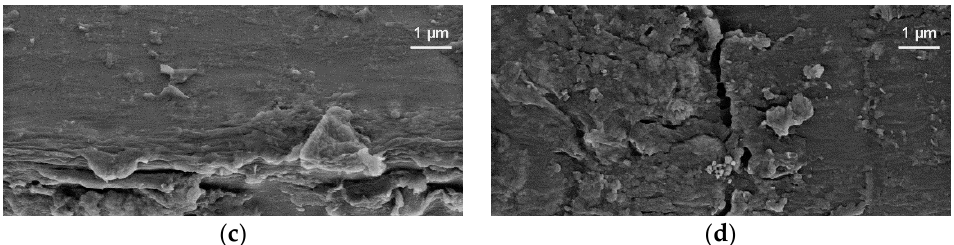
Figure 5. SEM images of two magnifications of flax fibres: ( a ) buffer, ( b ) buffer + laccase, ( c ) buffer + dopamine, ( d ) buffer + laccase + dopamine, after modification at 25 °C in each case.